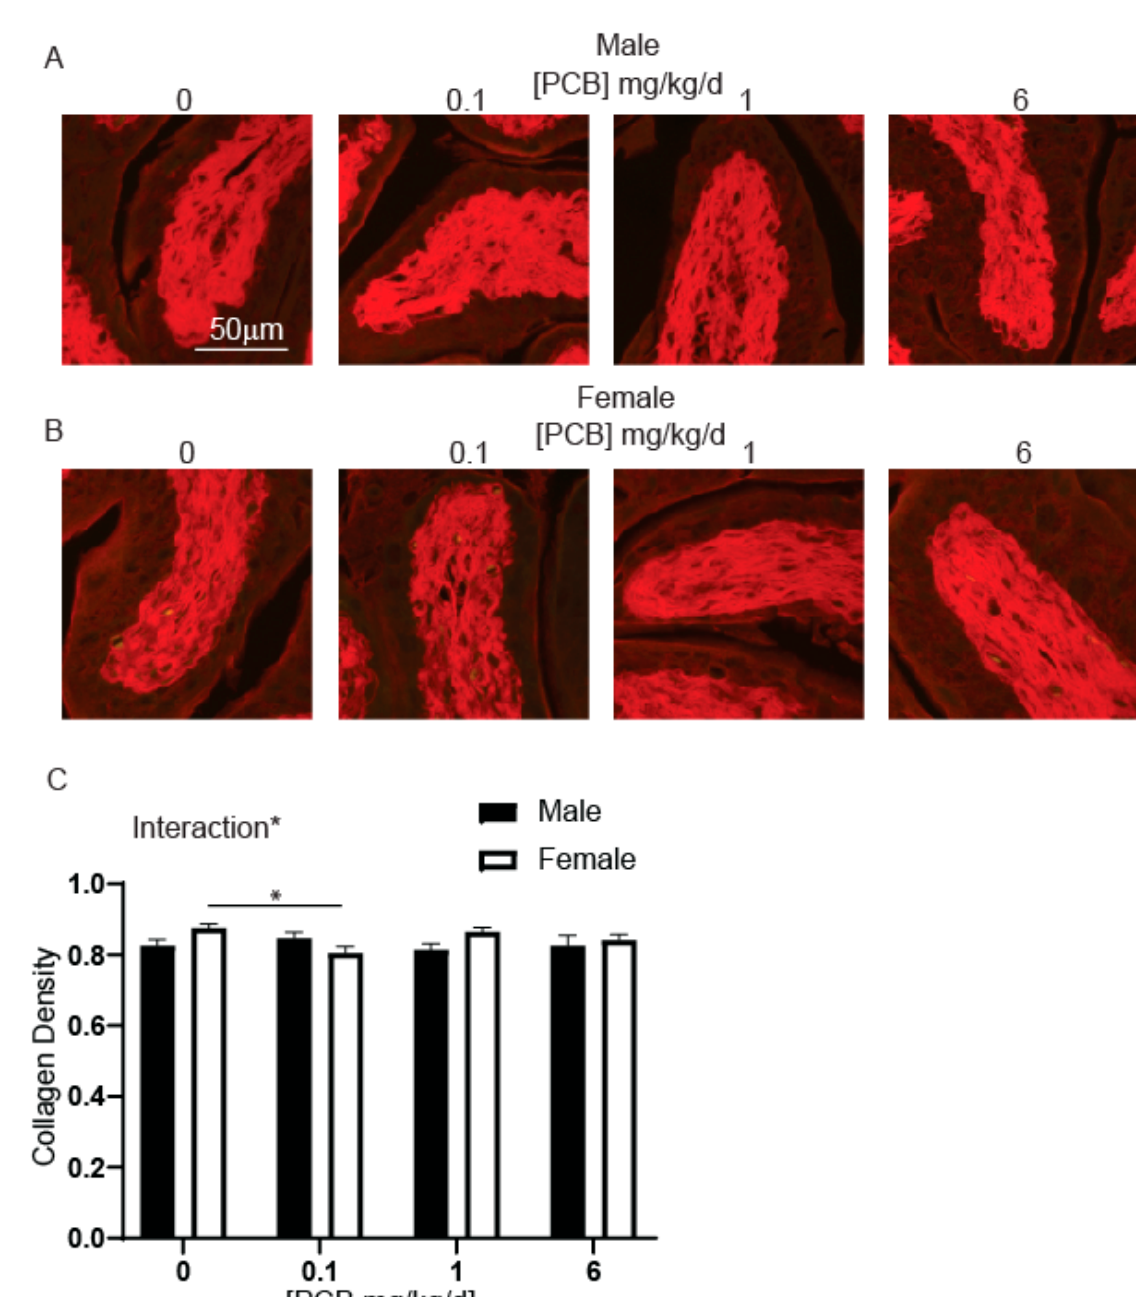
Figure 5. PCBs increase collagen density in bladder of developmentally exposed female mice. Mice were exposed to PCBs via maternal diet through gestation and lactation and bladders collected from young male and female offspring at postnatal day (P) 28–31. Slides were stained with picrosirius red to visualize collagen. Representative images of ( A ) male and ( B ) female mouse bladders at each PCB treatment group stained with picrosirius red to visualize collagen (red). Quantification of ( C ) ratio of collagen per unit area. Results are the mean ± SEM, n = 4–6 bladders per treatment group. Significant differences at p < 0.05 indicated by asterisk and asterisk and bar as determined using two-way ANOVA followed by Tukey’s multiple comparisons tests.